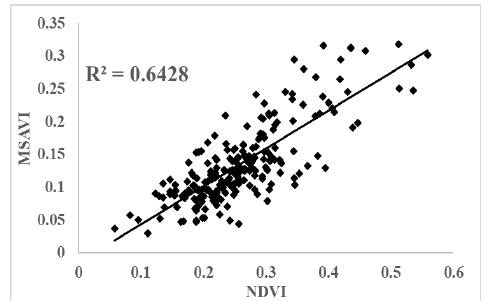
Fig.4 correlation comparison between PVI/MSAVI and NDVI